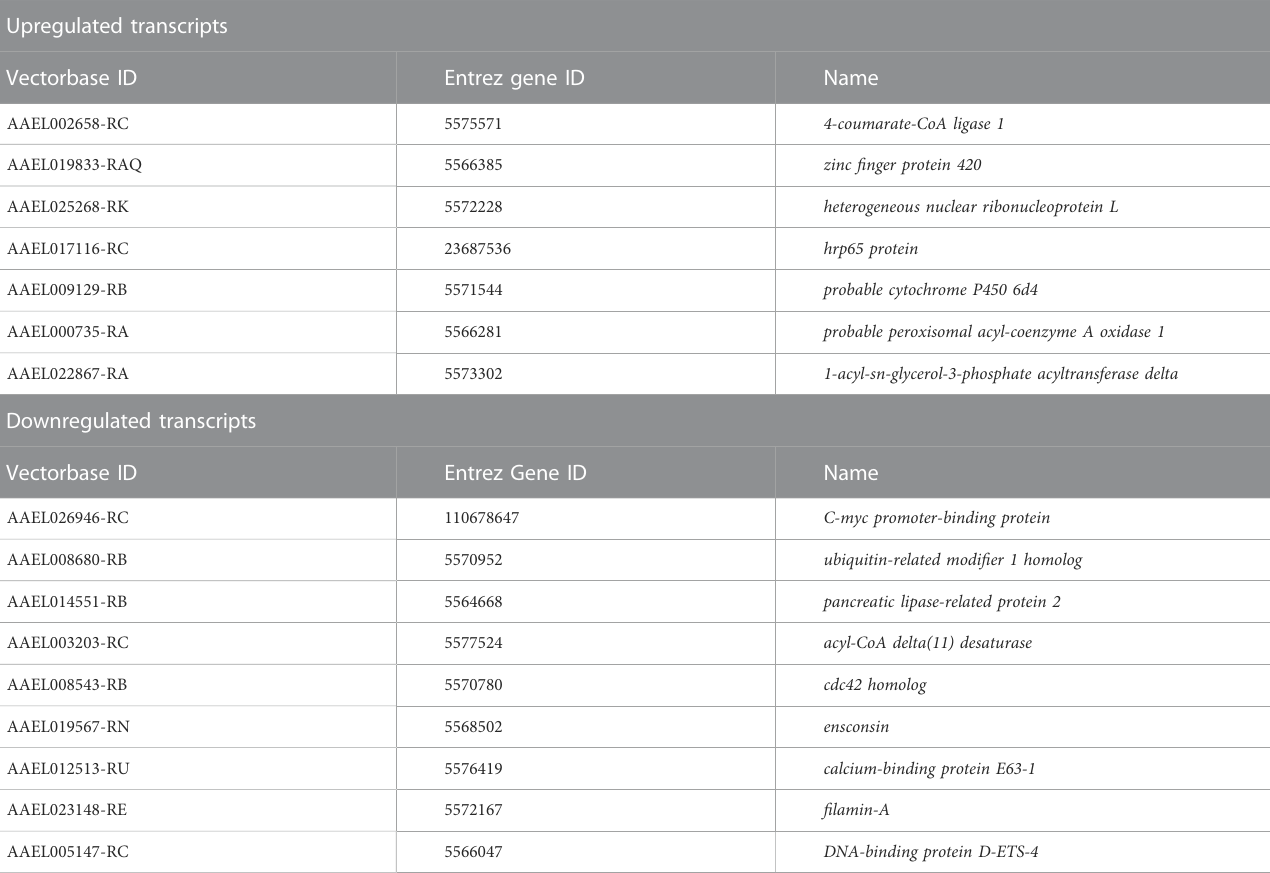
TABLE 4 Genes that may be involved in ethanol priming of mosquitoes for radiation treatment. These transcripts were identi fi ed to be signi fi cantly upregulated in ethanol-fed non-irradiated mosquitoes relative towater-fednon-irradiated mosquitoes andinwater-fedmosquitoes afterirradiation relative tonon-irradiated water- fed mosquitoes, or signi fi cantly downregulated in ethanol-fed non-irradiated mosquitoes relative to water-fed non-irradiated mosquitoes and in water-fed mosquitoes after irradiation relative to non-irradiated water-fed